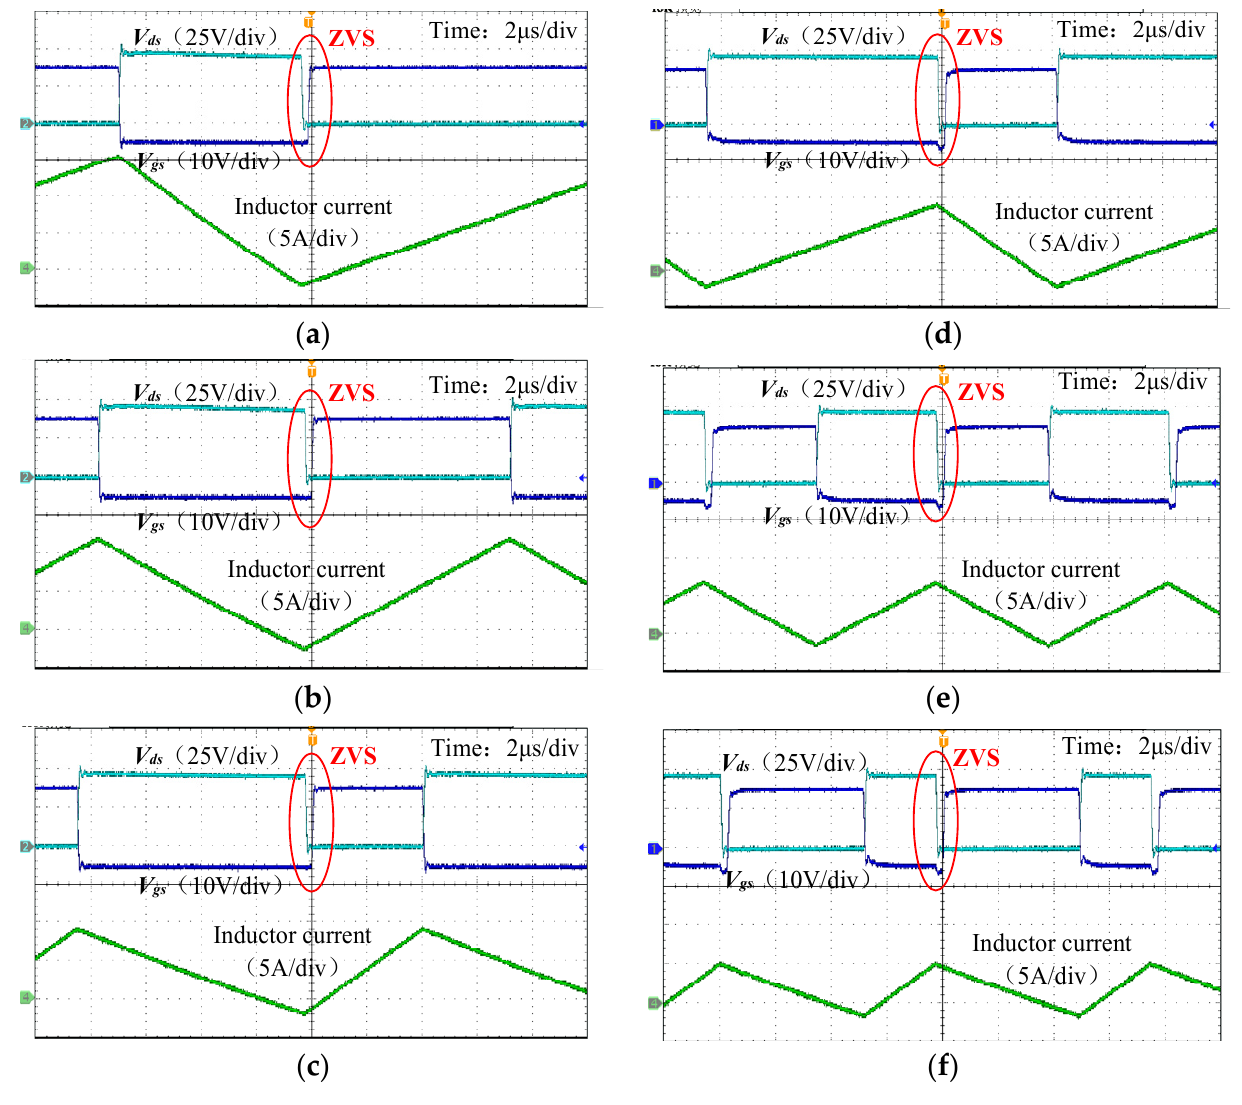
Figure 13. Experimental ZVS waveforms of the S 1 . ( a ) V LV = 16 V, full load; ( b ) V LV = 24 V, full load; ( c ) V LV = 32 V, full load. Experimental ZVS waveforms of the S 2 . ( d ) V LV = 16 V, half load; ( e ) V LV = 24 V, half load; ( f ) V LV = 32 V, half load.